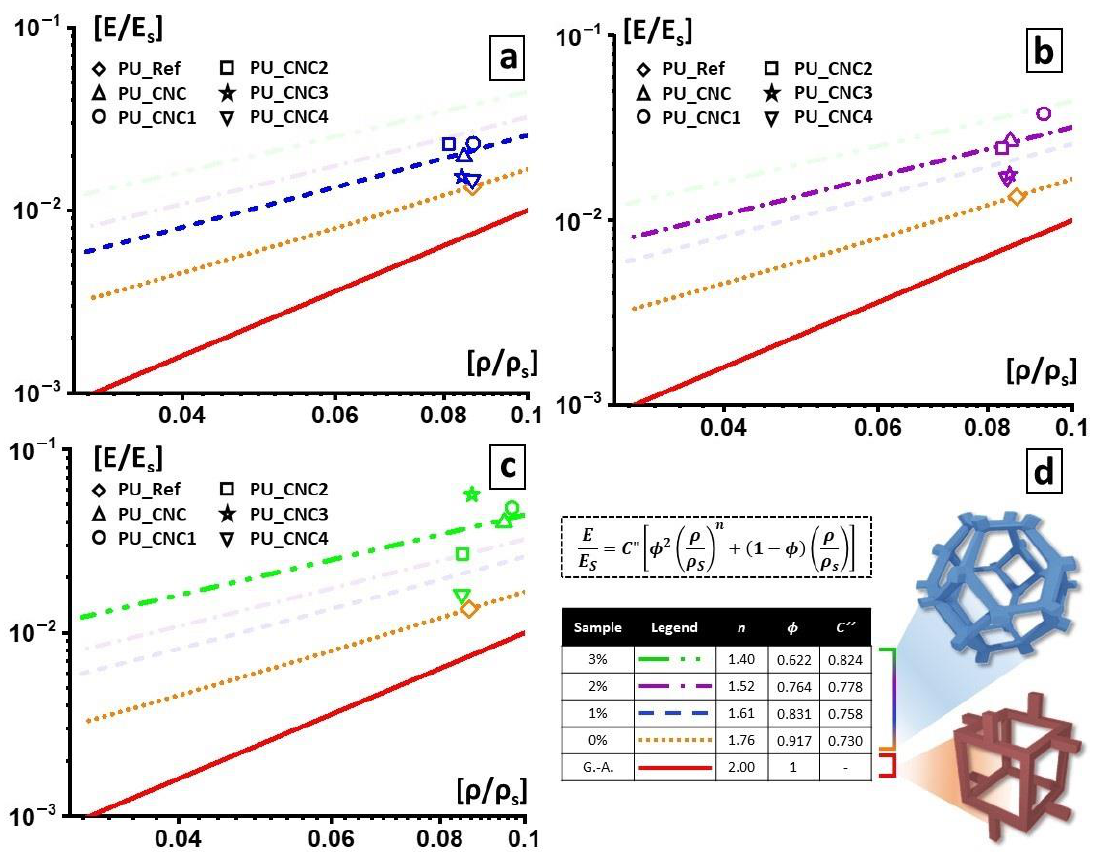
Figure 9. Graphical representation of modified Gibson–Ashby model of the foamed material. In ( a – c ) are reported the representative points and best fits relative to the analyzed materials. In particular, in red, the representative line of the Gibson–Ashby model for open cells; in orange, blue, purple and green line, the outcomes of the here-presented modified Gibson–Ashby model applied to PU-Ref, PU_CNCx_1, PU_CNCx_2 and PU_CNCx_3, with x associated to the corresponding modified CNC materials, respectively. In ( d ), the equation of the proposed model, the averages values of those presented in Table 6 (used for this analysis), and the schematic representation of the foam cells (top tetrakaidecahedral [55], bottom cubic [37]).